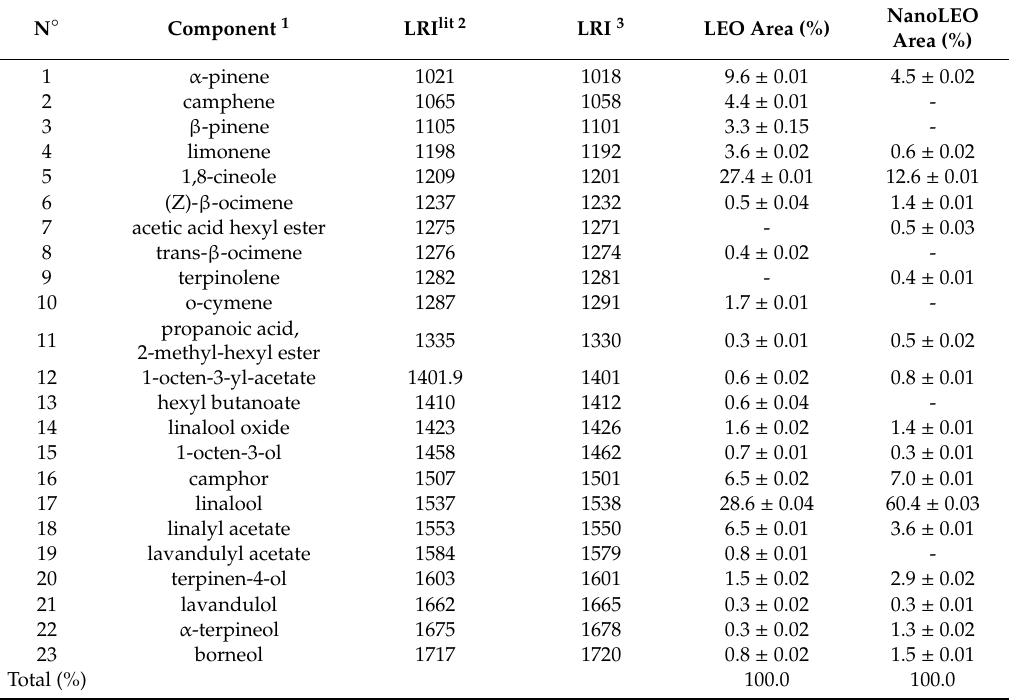
Table 1. Chemical composition (%) of lavandin essential oil (LEO) and